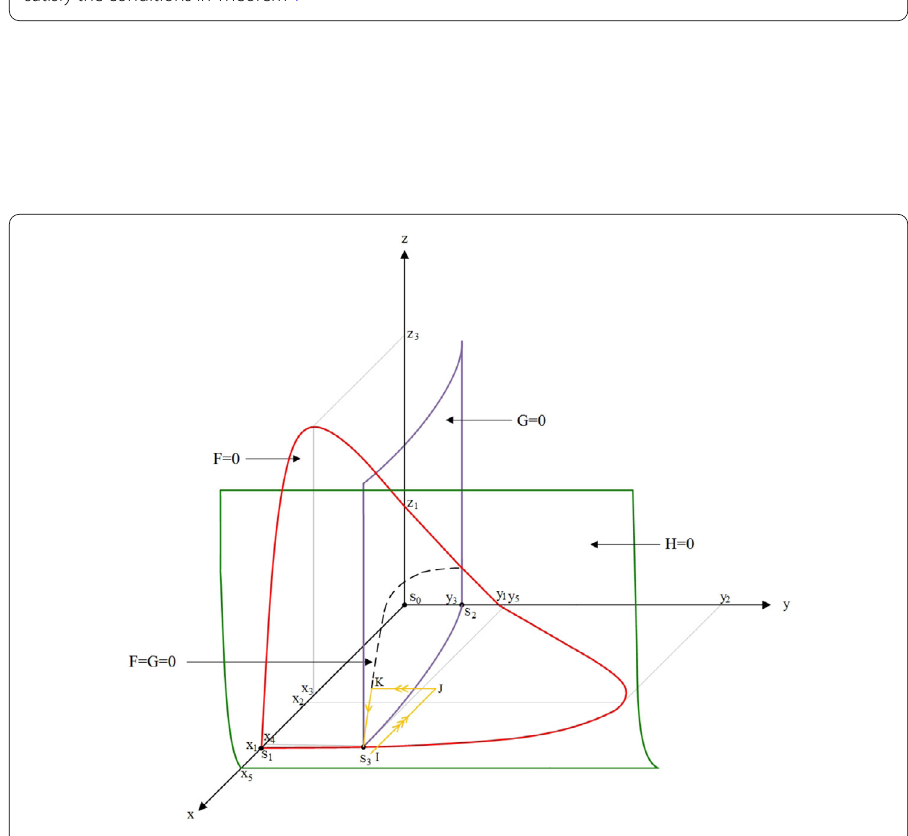
Figure 2 Shapes and relative positions of the manifolds where the parametric values of system of Eqs. (4)–(6) satisfy the conditions in Theorem